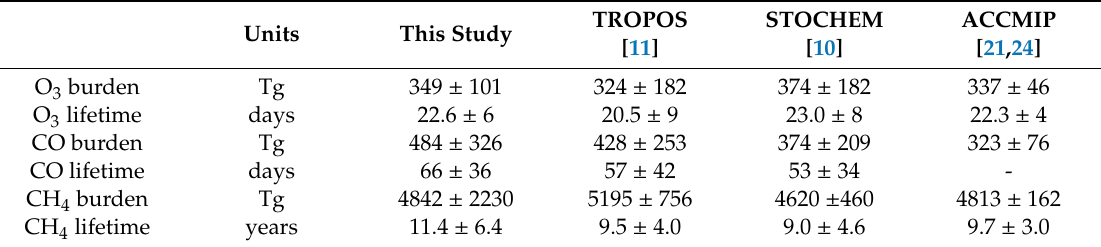
Table 1. Monte Carlo uncertainties estimated in this work and in the literature for the burdens and atmospheric lifetimes of tropospheric O 3 , CO and CH 4